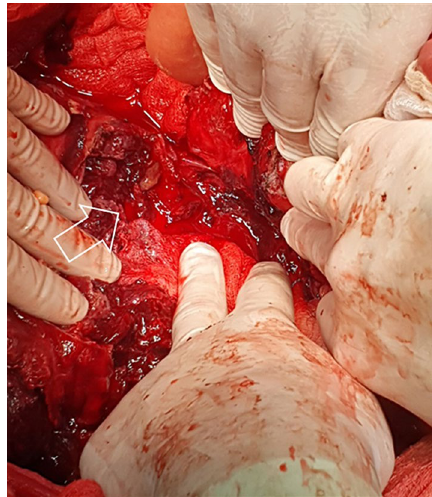
Fig. 3 Intraoperative photograph. The right part of the infracolic centromedial retroperitoneum is completely invaded by the mass which is actively bleeding from its necrotic surface areas (arrow)